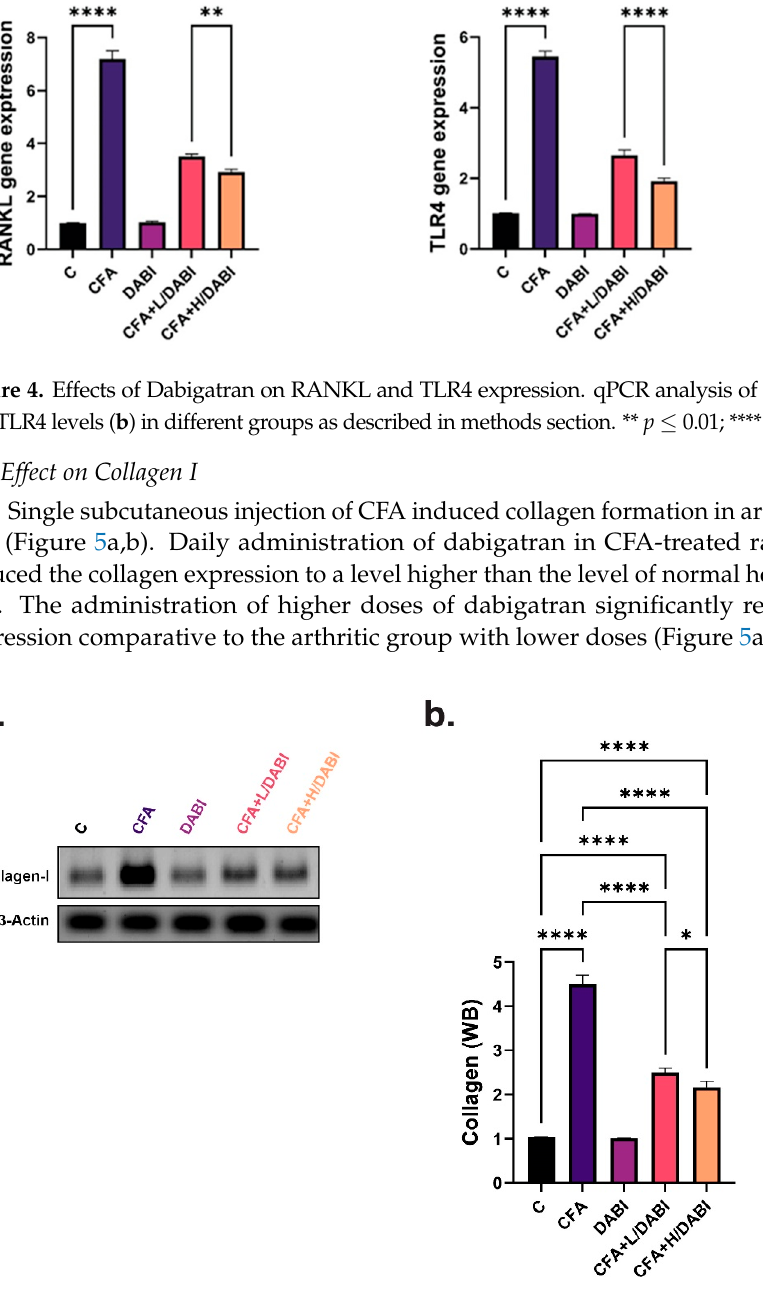
Figure 5. Immunoblot analysis of tissue Collagen. ( a ) Immunoblots of Collagen-1 and beta-Actin as a loading control. ( b ) Chemiluminescent analysis of band intensities of Collagen-1 in ( a ). * p ≤ 0.05; **** p ≤ 0.0001, ( n =